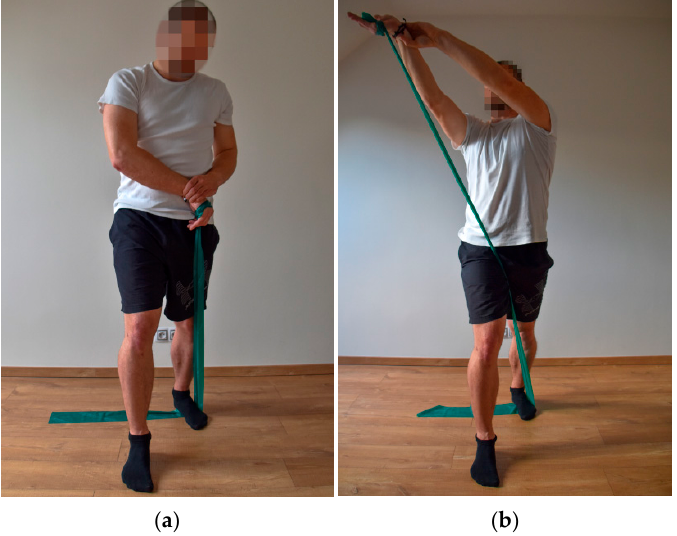
Figure 3. Extension and rotation of the upper torso—starting position ( a ) and end position ( b ).